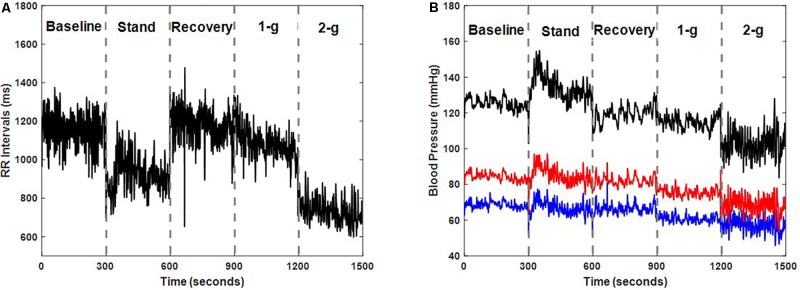
Dynamics of RR intervals (A) and blood pressure (B) i.e., systolic blood pressure (SBP) (black), diastolic blood pressure (DBP) (blue), and mean arterial pressure (MAP) (red) in response to different experimental conditions for one participant (male, age: 35 years, height: 175 cm, weight: 76 kg).